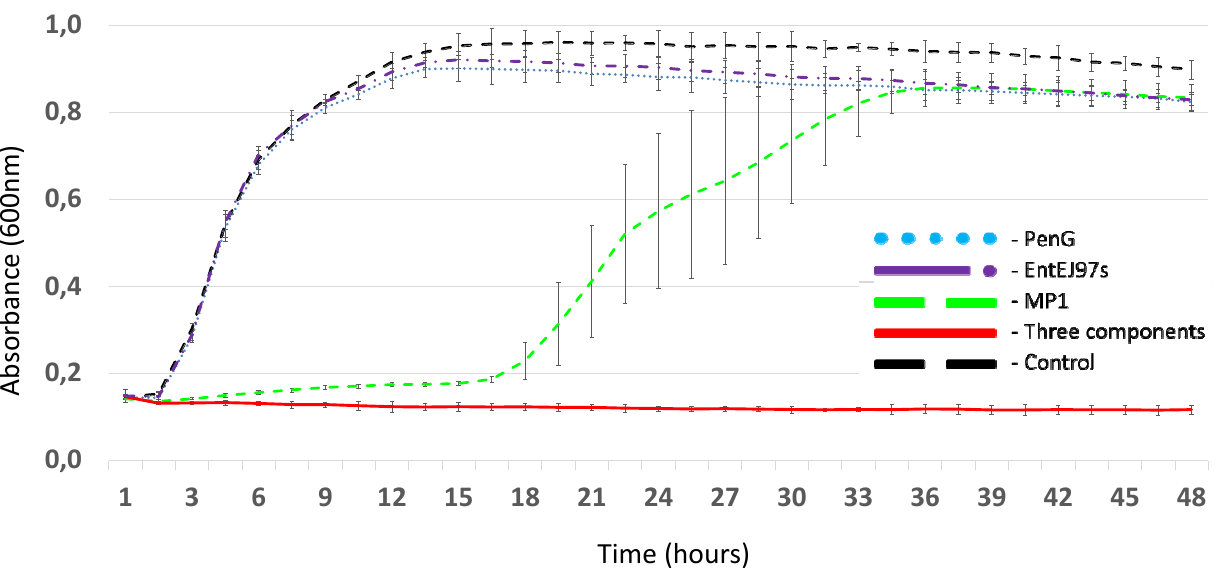
Figure 1. Growth curves of LMGT 4219 in the presence of different antimicrobials: PenG (5 µg/mL), EntEJ97s (1 µg/mL), MP1 (0.2 µg/mL) and a combination of all three antimicrobials at the same concentrations. Control: LMGT 4219 without antimicrobials. Error bars shown mean +/ − SD of